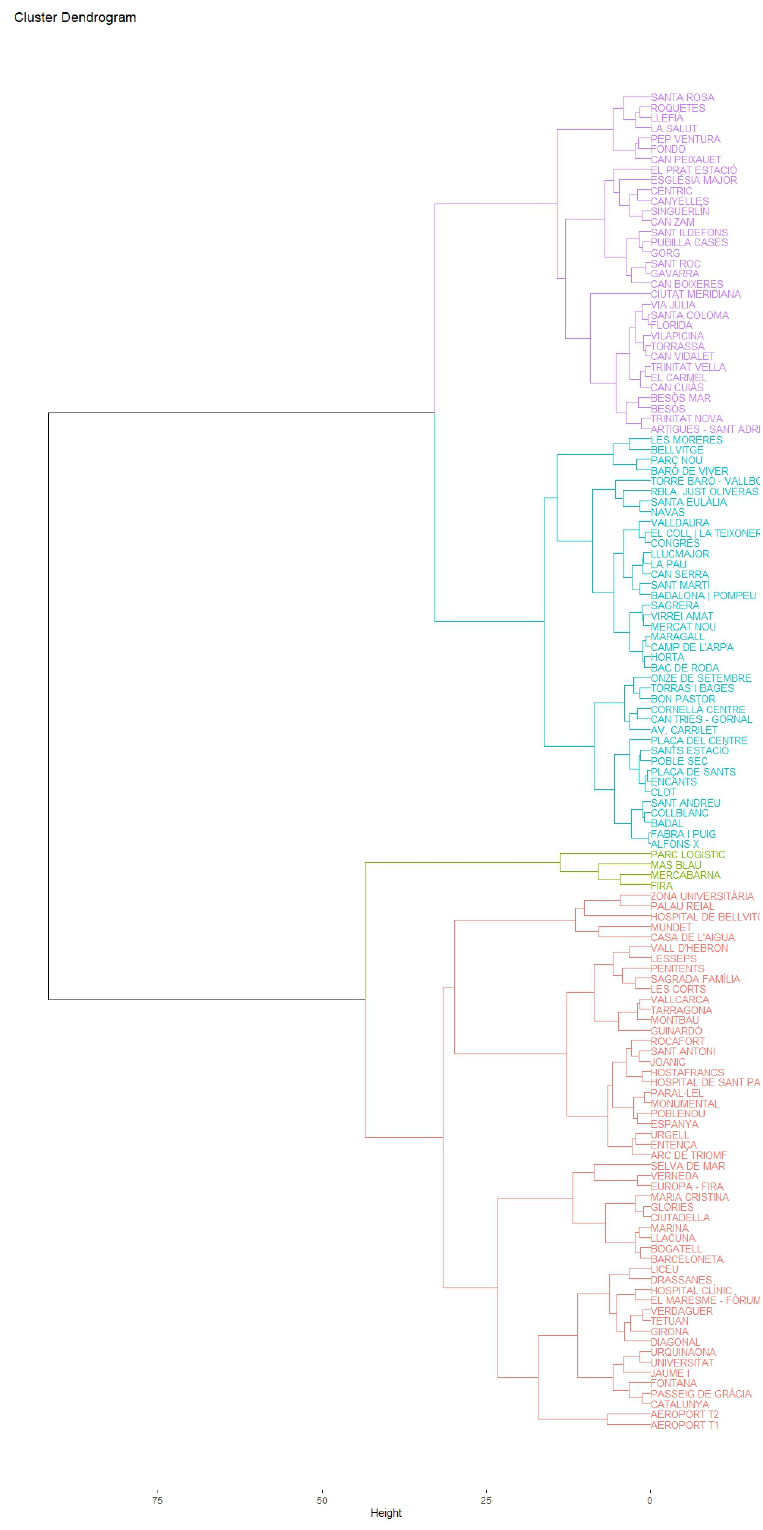
Figure 11. Clusters: Hierarchical